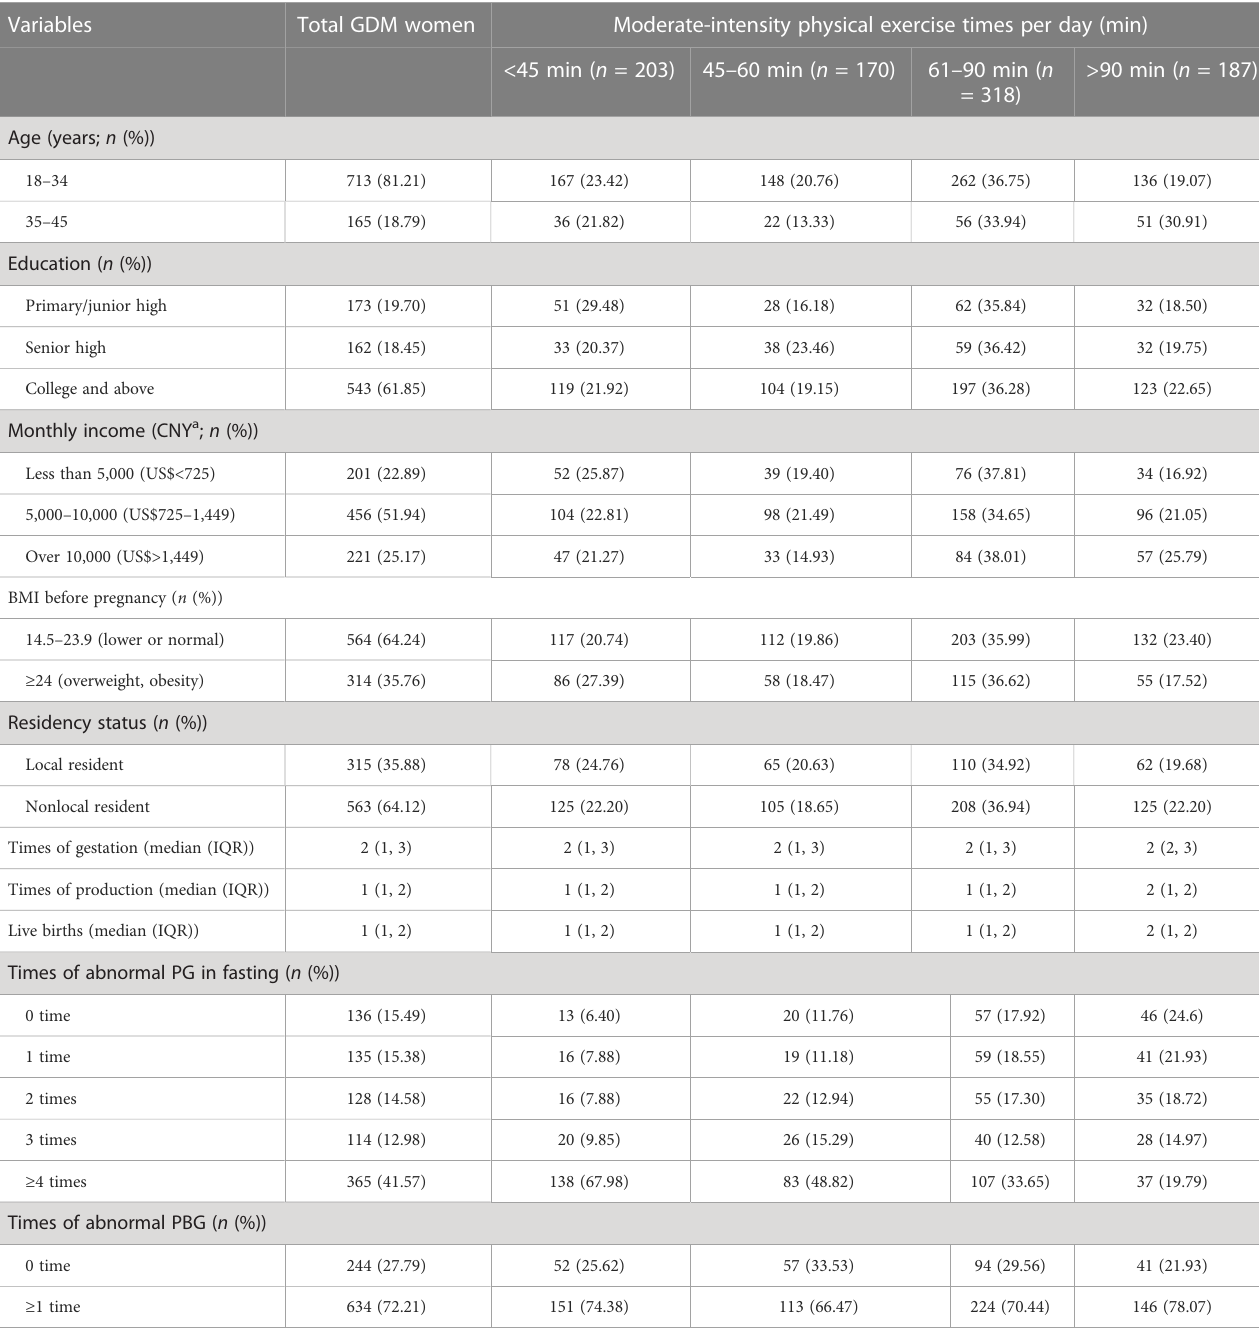
TABLE 3 The demographic feature in women with gestational diabetes mellitus (GDM) with different physical exercise times in Shanghai, China ( n = 878).